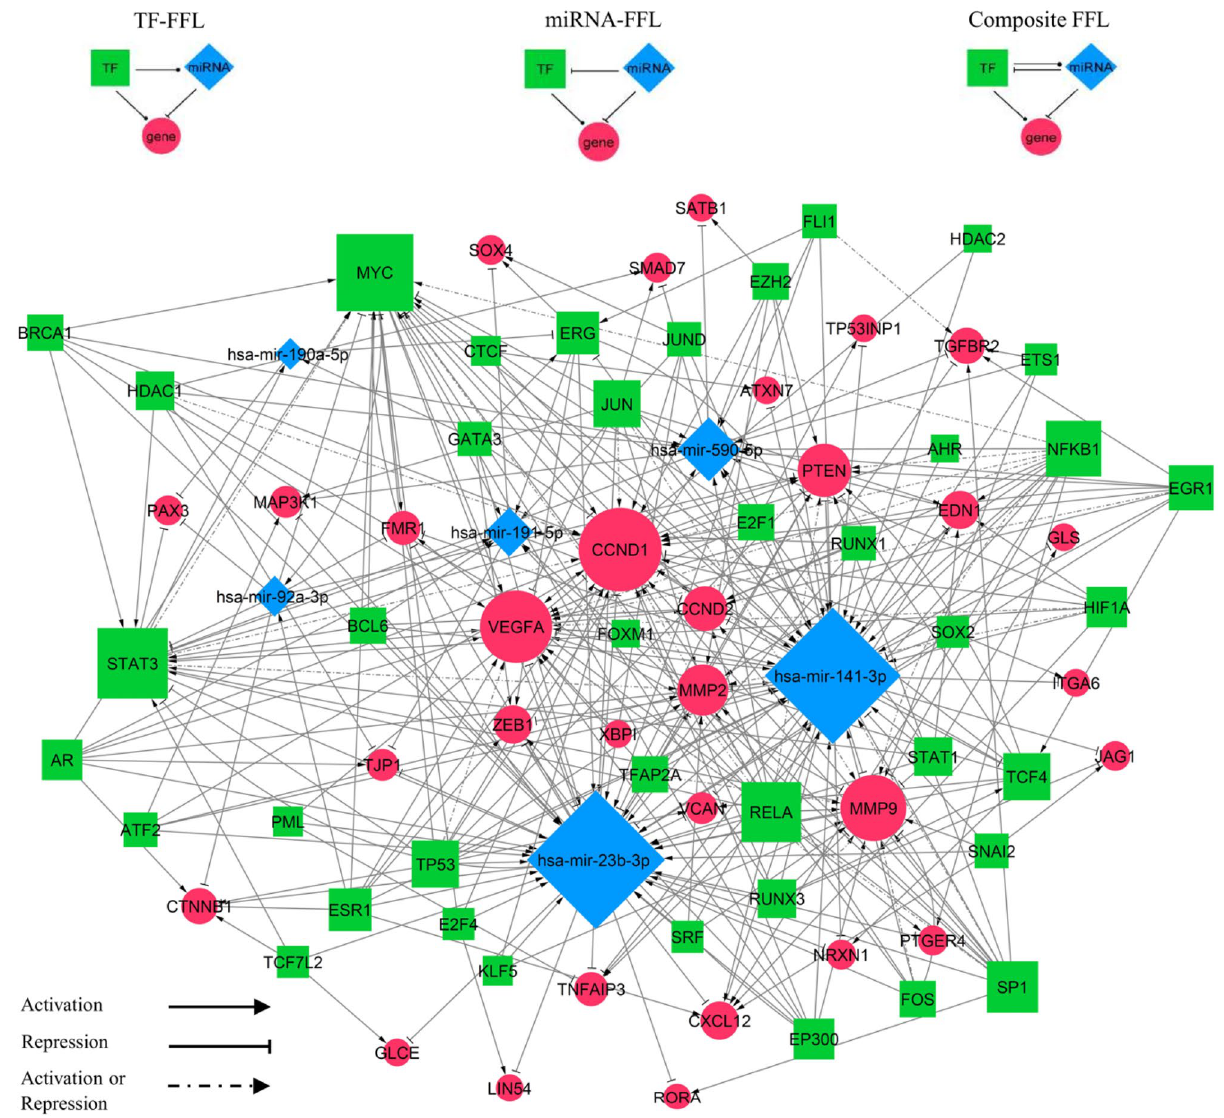
Figure 6. The miRNA-TF co-regulatory network. Blue diamonds represent miRNAs, green squares represent transcription factors (TFs), and red circles represent target genes. The size of the node correlates to the degree of the